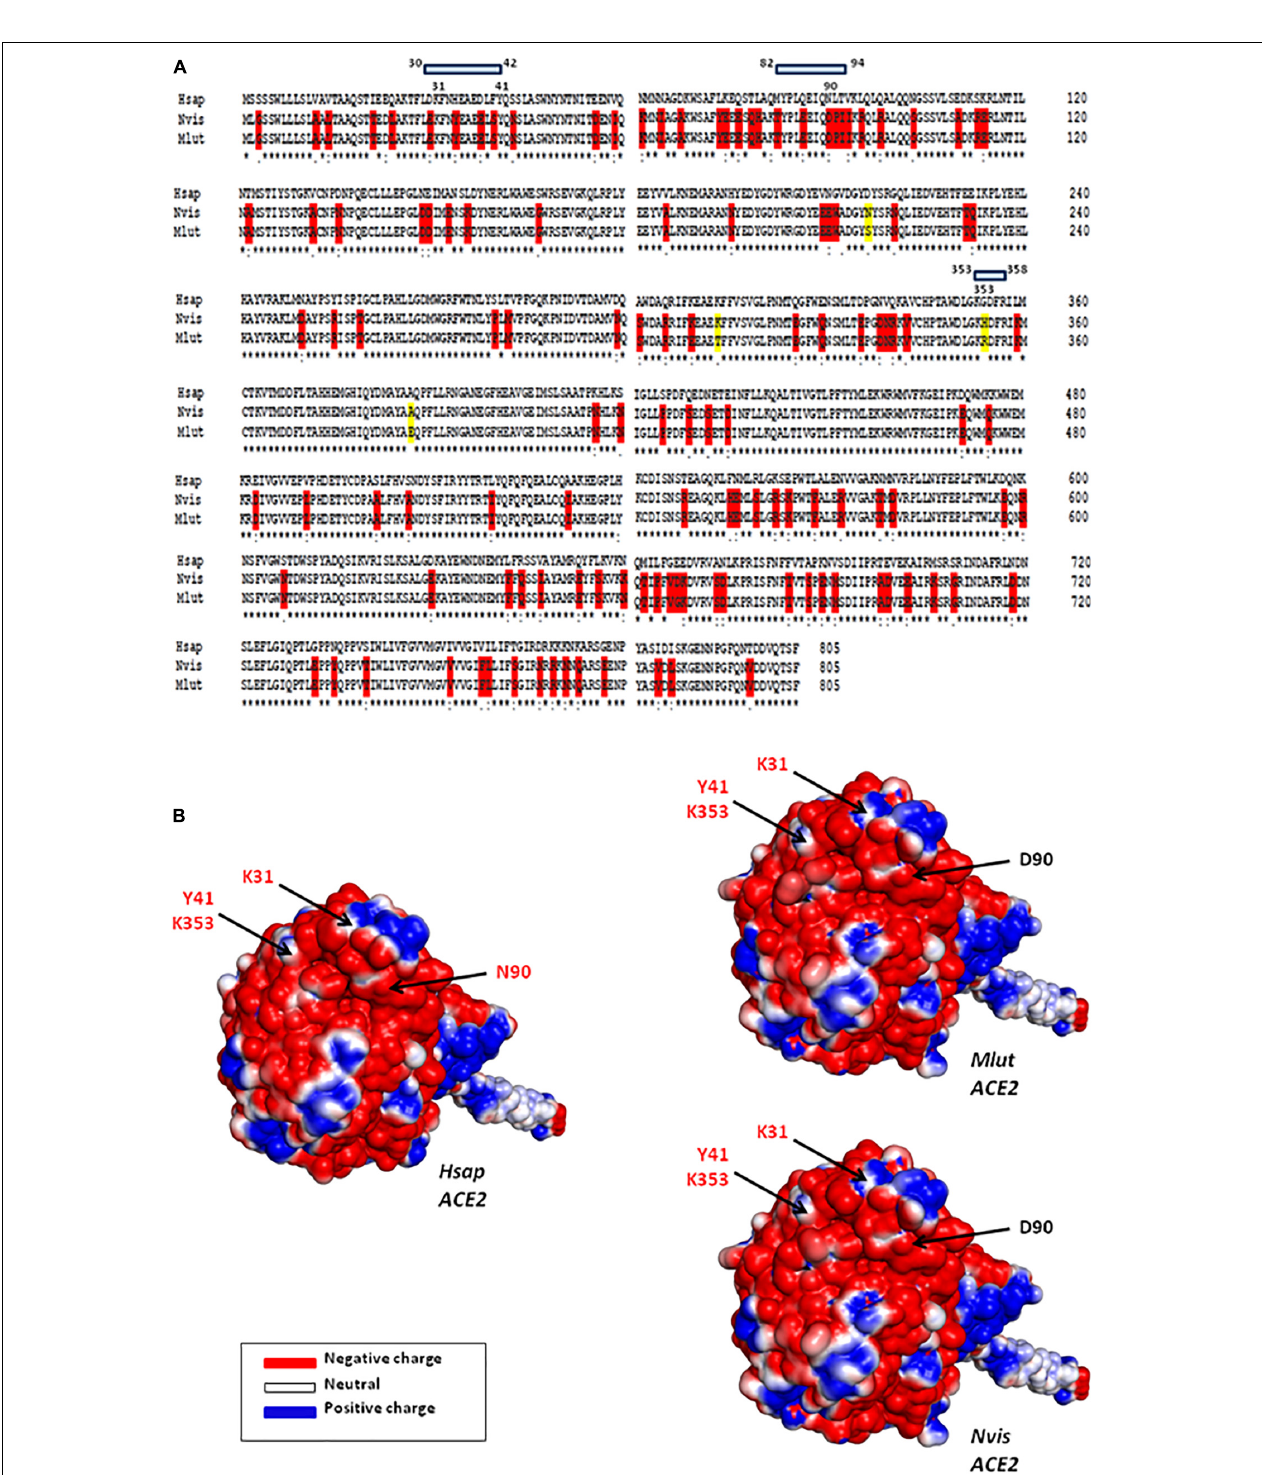
FIGURE 4 | Mink ACE2 sequences alignment. (A) Clustal Omega multiple sequence alignment (EMBL-EBI bioinformatic tool; Copyright EMBL 2020) was used to compare the ACE2 protein sequences of H. sapiens (Hsap) and minks N. vison (Nvis) and M. lutreola (Mlut). The amino acids that differ between human and minks are shown in red and those which differ between minks are shown in yellow. Some of the amino acids important for viral tropism are indicated in blue (previous studies showed that amino acid residues 31, 41, 90, and 353 are important for viral spike binding). (B) 3D model of ACE2 designed using the Phyre2 server (this model lacks the cytoplasmic tail of ACE2). An electrostatic potential surface (red: negative charge; blue: positive charge) was generated using PyMOL 1.8.0 and APBS tool plugin. The location of amino acids 31, 41, 90, and 353 is indicated by arrows.